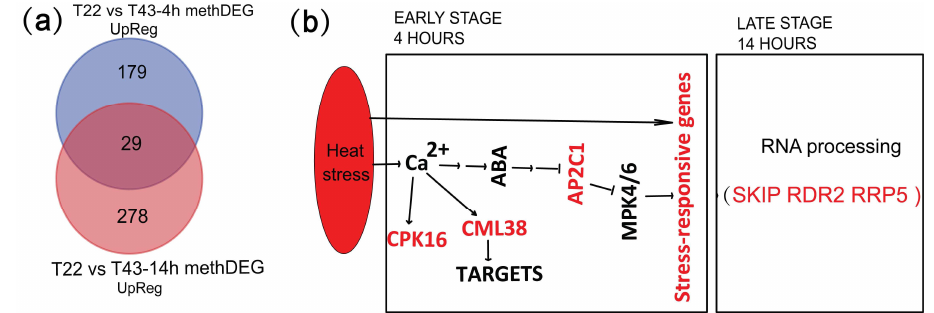
Figure 7. Models of methDEGs involved in heat stress response. ( a ) Venn diagram of unique and shared upregulated methDEGs between T22 vs. T43-4h and T22 vs. T43-14h; ( b ) general model of DNA methylation specifically involved in the modulation of heat stress response genes at the early and late stage of heat stress.